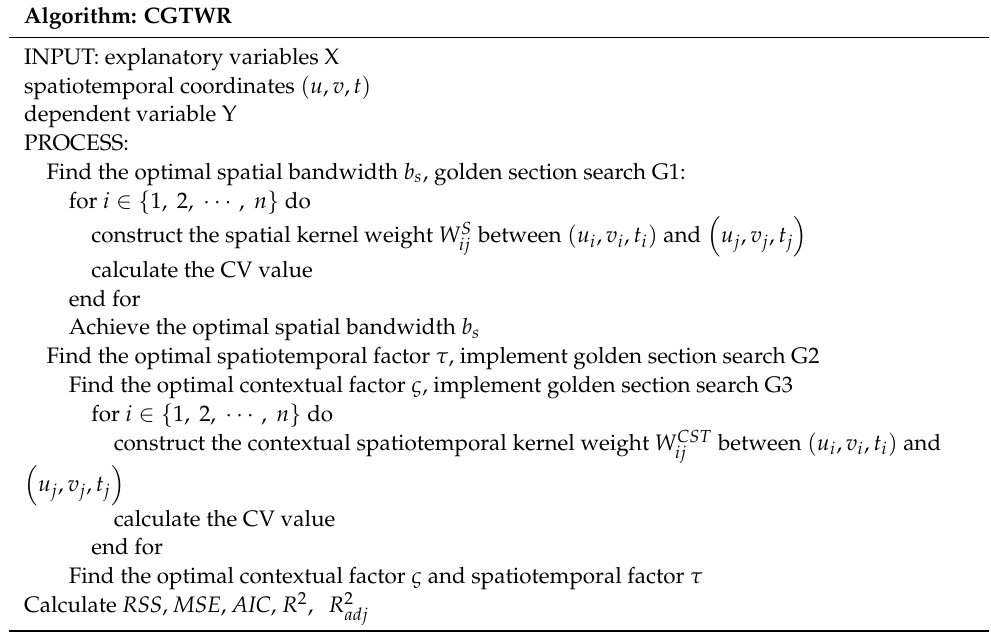
Algorithm 1. Pseudo-code describing the CGTWR